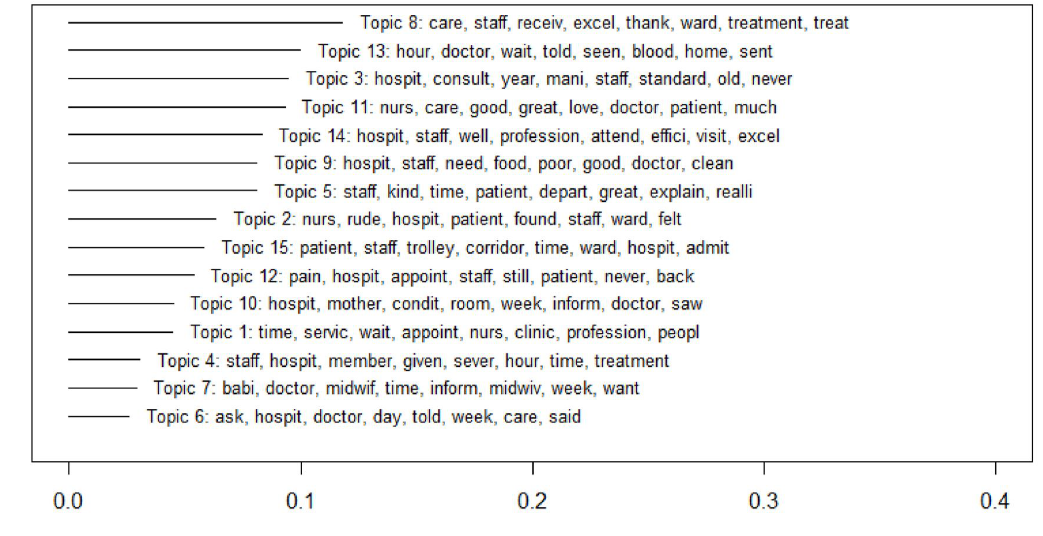
Figure 5: Presentation of paper